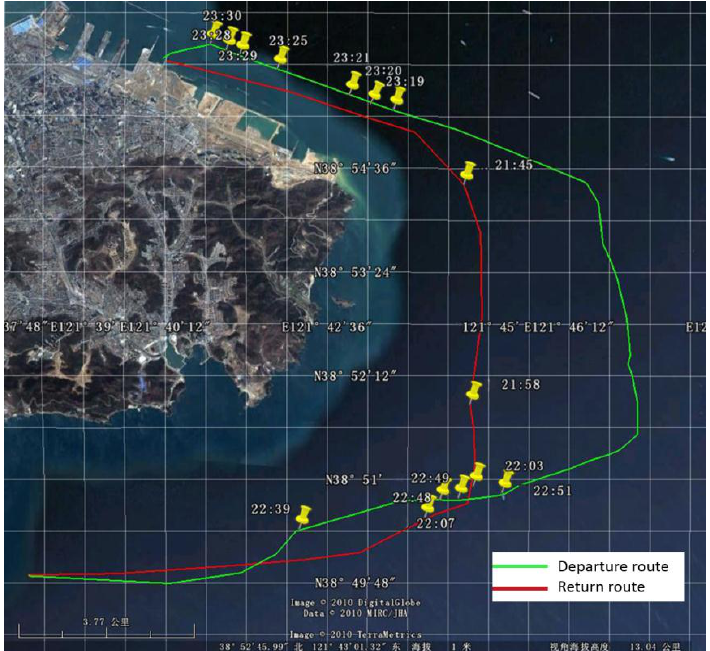
Figure 1. Navigation route of the teaching-training ship “YUKUN” on 21 July 2010.